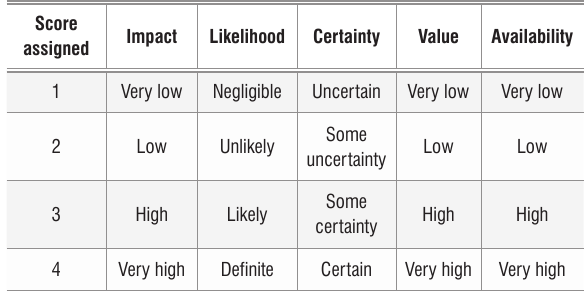
Table 1. Scores used by participants in the risk–benefit analyses of various management strategies